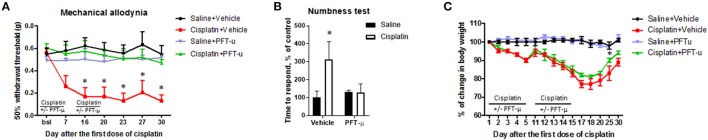
Pifithrin-μ prevents mechanical allodynia and sensory dysfunction in a mouse model of chemotherapy-induced peripheral neuropathy. Mice (n = 8 per group) were treated with cisplatin (2 cycles of 2.3 mg/kg/day for 5 days followed by 5 days rest, resulting in a cumulative dose of 23 mg/kg) + vehicle, cisplatin + pifithrin-μ (PFT-μ) (2 cycles of 6 daily injections of 8 mg/kg i.p starting 1 day before cisplatin), or saline + vehicle. (A) Mechanical allodynia was monitored over time with von Frey hairs. Data represent mean and SEM of 50% withdrawal threshold. Two-way repeated-measures analysis of variance (ANOVA) identified a group effect (P < 0.0001) [F(3, 24) = 97.40], a time effect (P < 0.0001) [F(6, 144) = 8.59], and a group × time interaction effect (P < 0.0001) [F(18, 144) = 8.66]; Tukey post-hoc test: *P < 0.0001 cisplatin + vehicle vs. all other groups. (B) Effect of cisplatin and PFT-μ on numbness (sensory function) as detected in the adhesive removal test; the time to display a behavioral response to an adhesive patch placed on the hind paw was recorded. Two-way ANOVA revealed a group effect (P < 0.005) [F(1, 28) = 11.96], a treatment effect (P < 0.05) [F(1, 28) = 11.75], and group × treatment interaction (P < 0.005) [F(1, 28) = 4.69]; Tukey post-hoc test: *P < 0.001 cisplatin + vehicle vs. all other groups. (C) Change in body weight after cisplatin and PFT-μ treatment. Two-way ANOVA, multiple comparisons: *P < 0.01 between cisplatin + vehicle vs. cisplatin + PFT-μ on day 25 (marked with an asterisk).